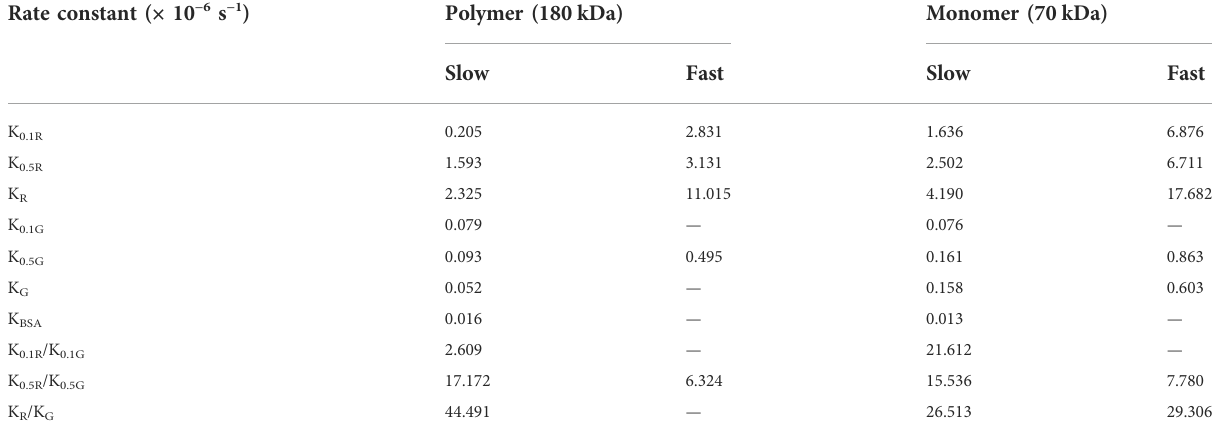
TABLE 1 First-order rate constants of BSA riboglycation and glucoglycation as calculated by Tsou ’ s method (Tsou,